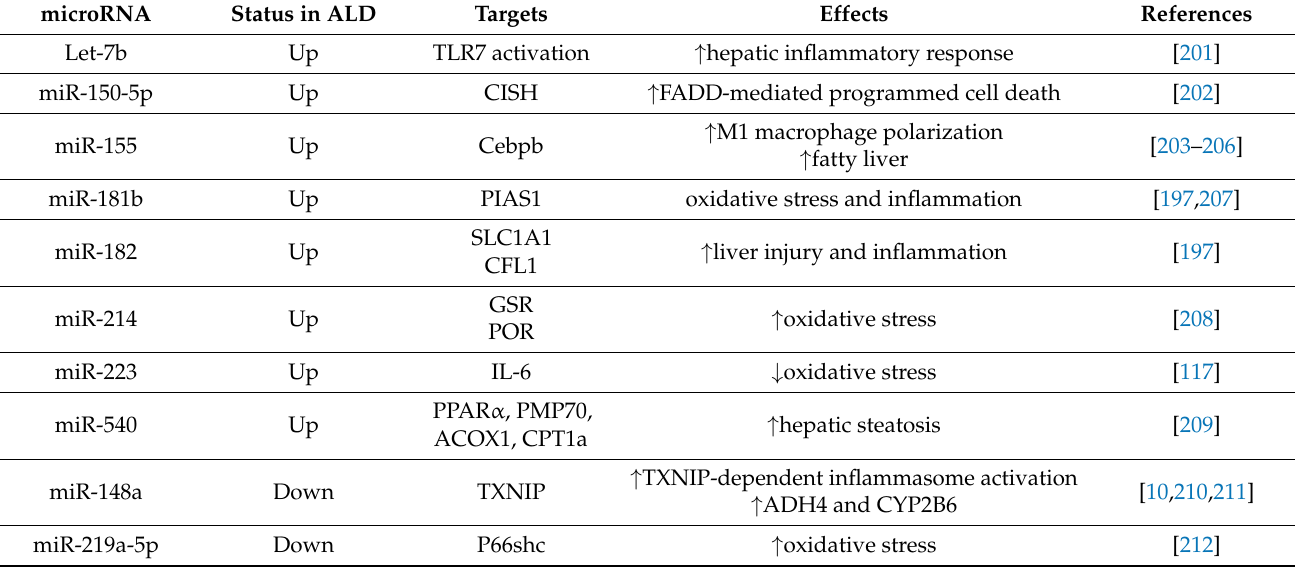
Table 1. Aberrant microRNA expression in ALD and the associated pathological